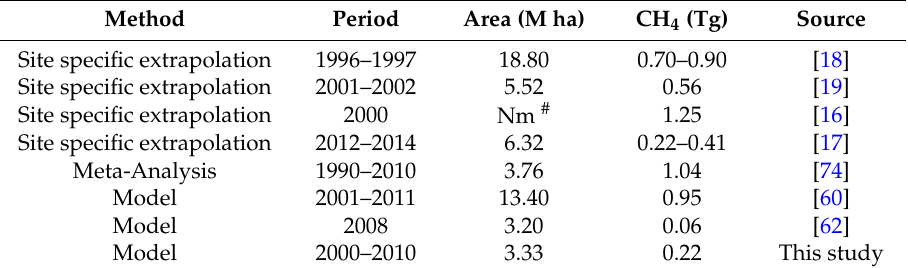
Table 3. Regional CH 4 estimations from wetlands in the Tibetan Plateau after